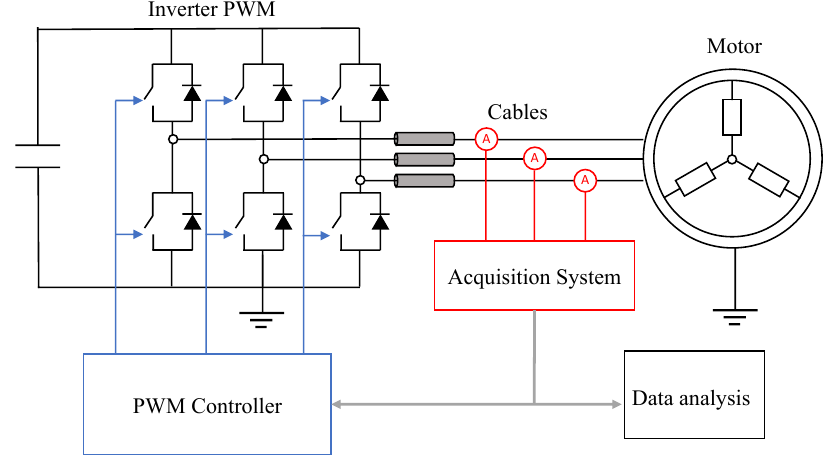
Figure 10. Schematic overview of the test-bench ageing